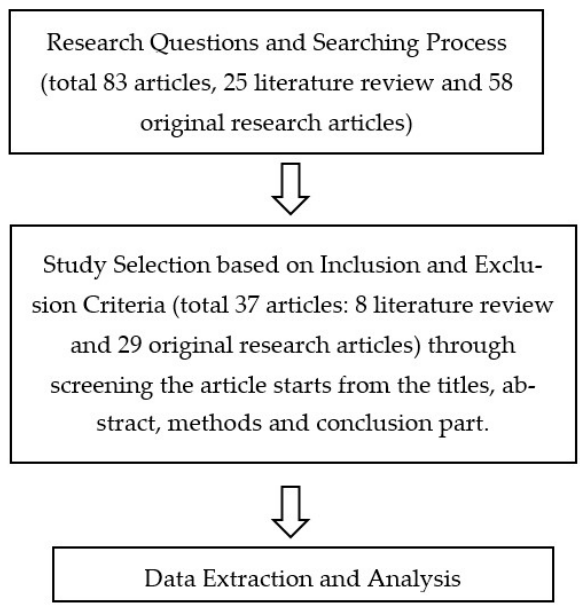
Figure 1. Protocol study for the literature review.